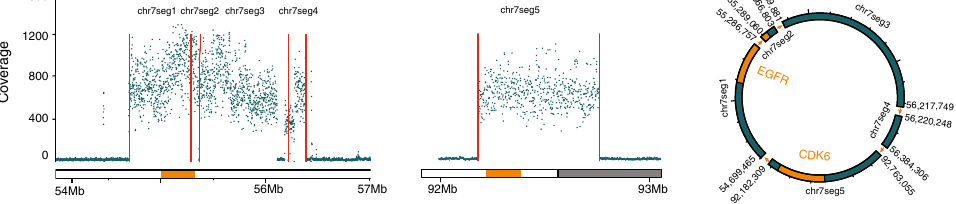
entire genome (9.2%) (Supplementary Fig. 2g). These focal ampli fi cations are also identi fi ed at regions of small RNAs (Fig. 1c), including miRNAs (302 sites), SnRNAs (130 sites), SnoRNAs (63 sites), and rRNAs (37 sites). Interestingly, we found that 82 focal ampli fi cations containing canonical oncogenes ( CDK12 was reported as a tumor suppressor gene but with oncogenic properties 38 ) (Fig. 1c). Next, we focused on